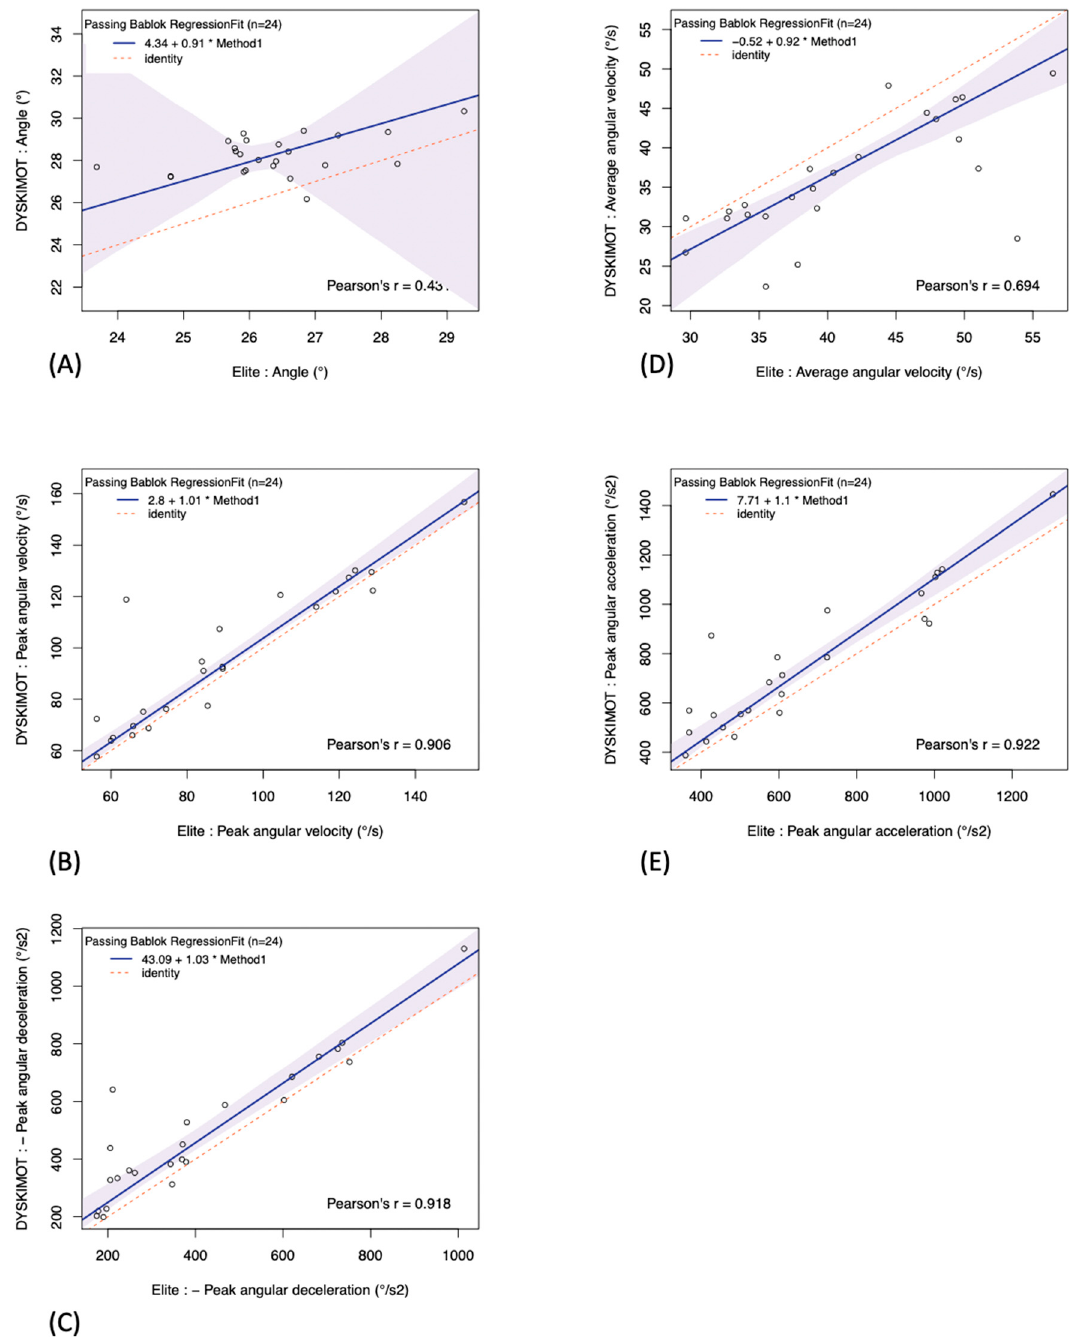
Figure 8. Passing-Bablok regressions showing the individual parameters computed from the DYSKIMOT and Elite data (points): ( A ) Angle, ( B ) Peak angular velocity, ( C ) Peak angular deceleration, ( D ) Average angular velocity, ( E ) Peak angular acceleration. The regression line (solid line) is given and compared to the identity line (dotted line). The 95% confidence interval for the linear fit is also displayed (colored band).